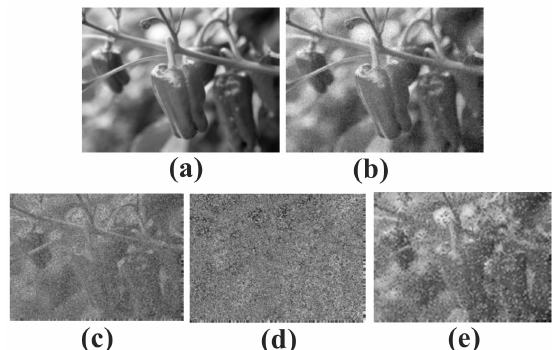
Figure 6. Results of decomposition by BEMD for the raw Pepper image: ( a ) the original image, ( b ) the noise polluted image, ( c ) the decomposed BIMF 1, ( d ) the decomposed BIMF 2, ( e ) the